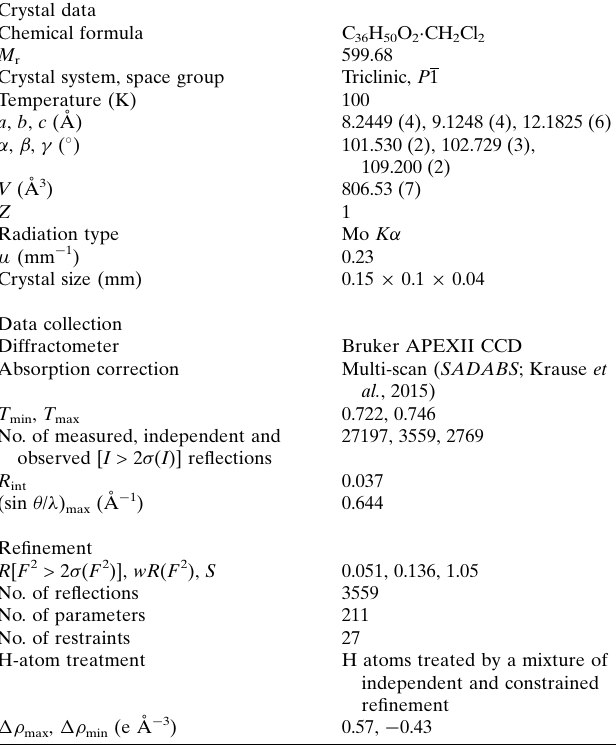
Crystal data Chemical